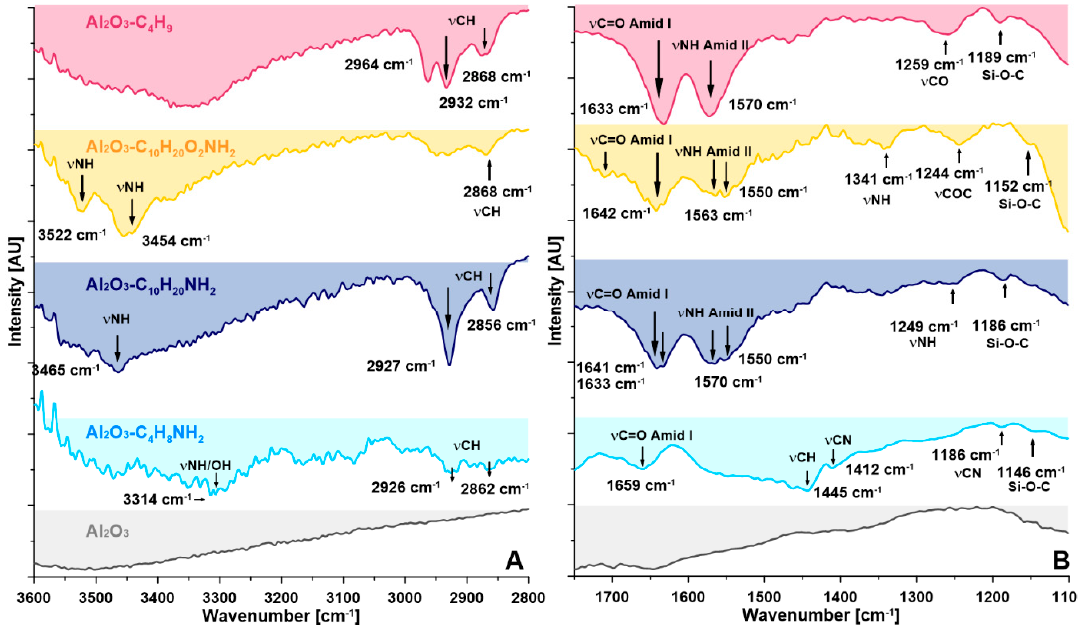
Figure 2. ATR-FTIR spectra of pristine and modified samples. ( A ) In the range of 3600–2800 cm − 1 ; ( B ) at the range of 1750–1100 cm − 1 .